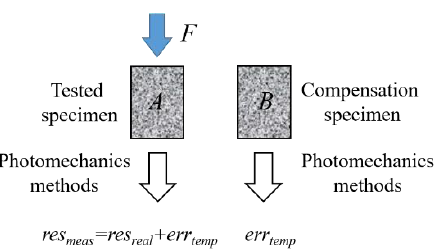
Figure 15. Principle of the compensation specimen method.